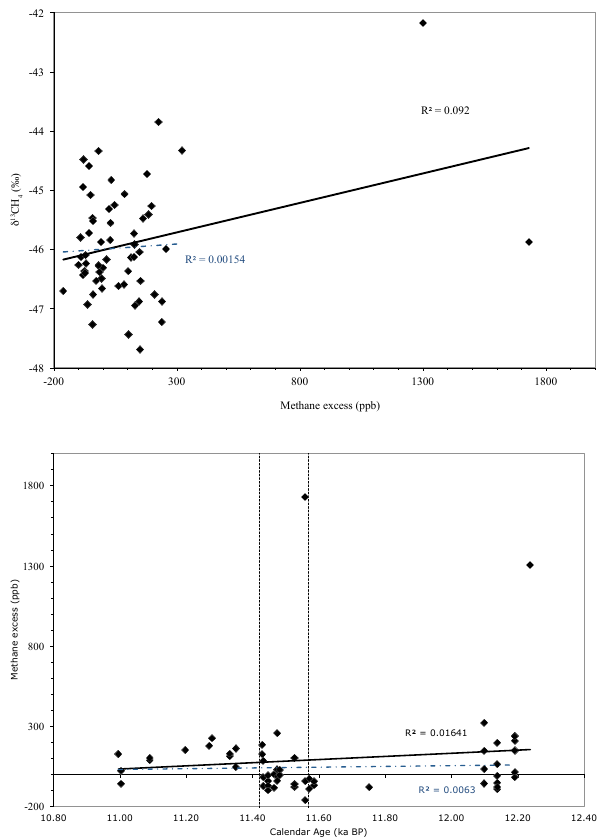
Fig. 5. P˚akitsoq excess CH 4 plotted against gas age and δ 13 CH 4 values. Excess CH 4 is defined as the difference between P˚akitsoq IRMS-derived [CH 4 ] and GISP2 (Brook et al., 2000). Linear trend lines and r 2 values are shown considering all points (solid black) or all points excluding the two major outliers ( > 1000ppb CH 4 excess)(dashed blue). Top panel: δ 13 CH 4 value as a function of methane excess. Bottom panel: methane excess as a function of gas age. The vertical dashed lines denote the start and end of the YD-PB transition as shown in Figs. 1 and 2.